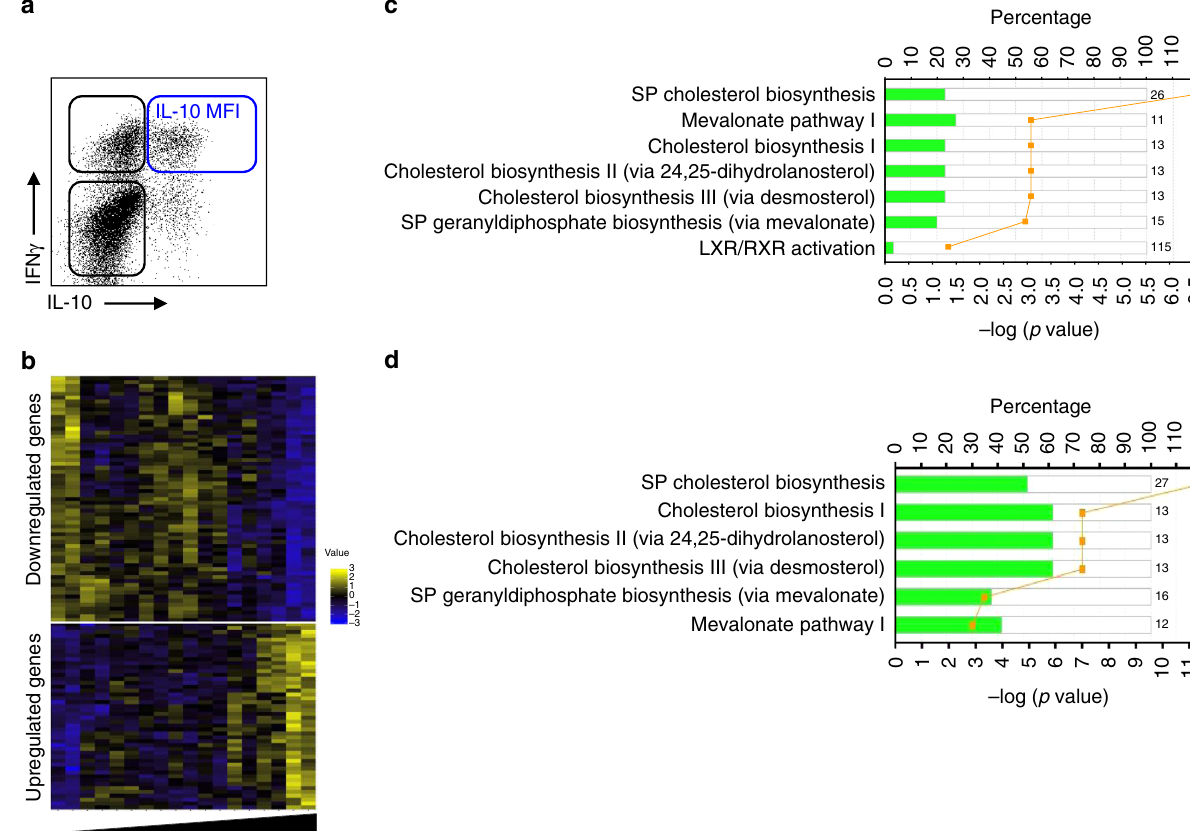
PCR (qPCR) for selected genes within the CBP (Supplementary Figure 1d).